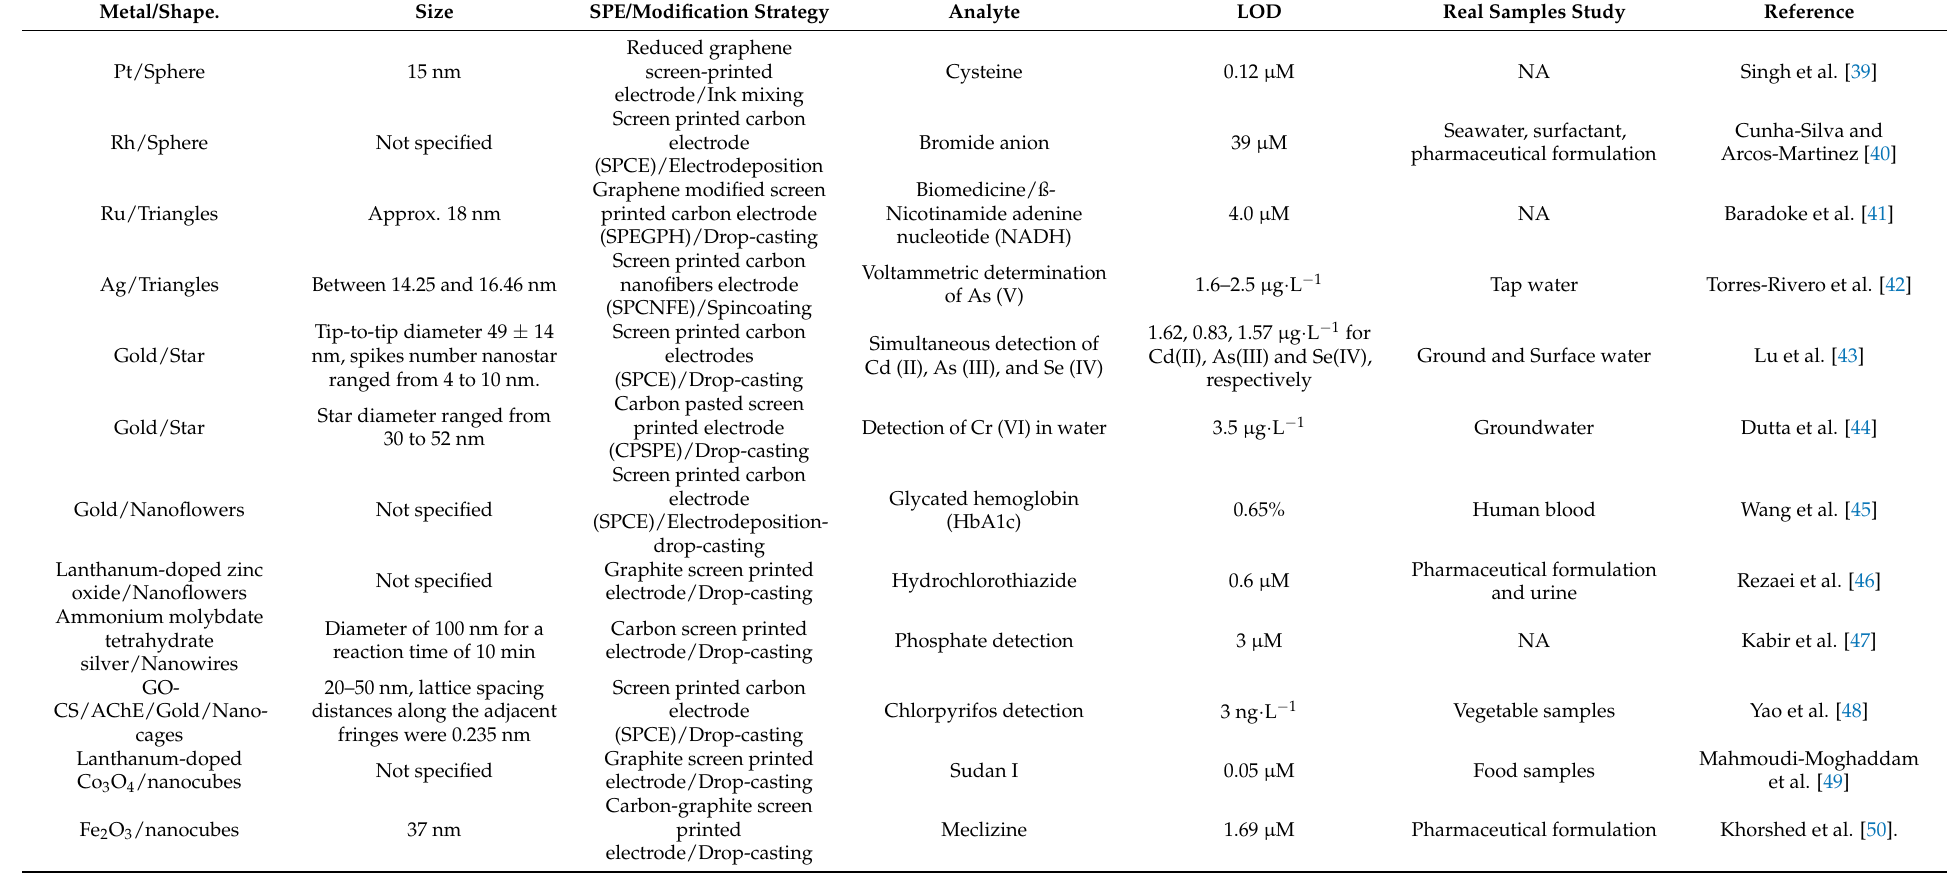
Table 1. Summary of relevant shaped NPs and their electroanalytical